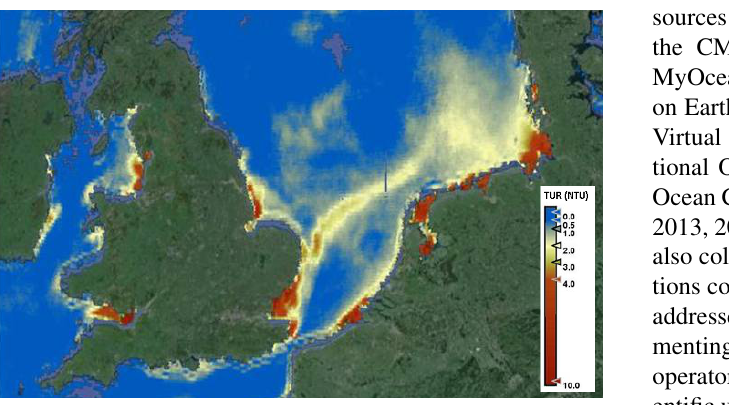
Figure 2. East Anglian plume from MSG-2 SEVIRI. A monthly mean of SEVIRI water turbidity for July 2008 is depicted. Turbidity is expressed in the nephelometric turbidity